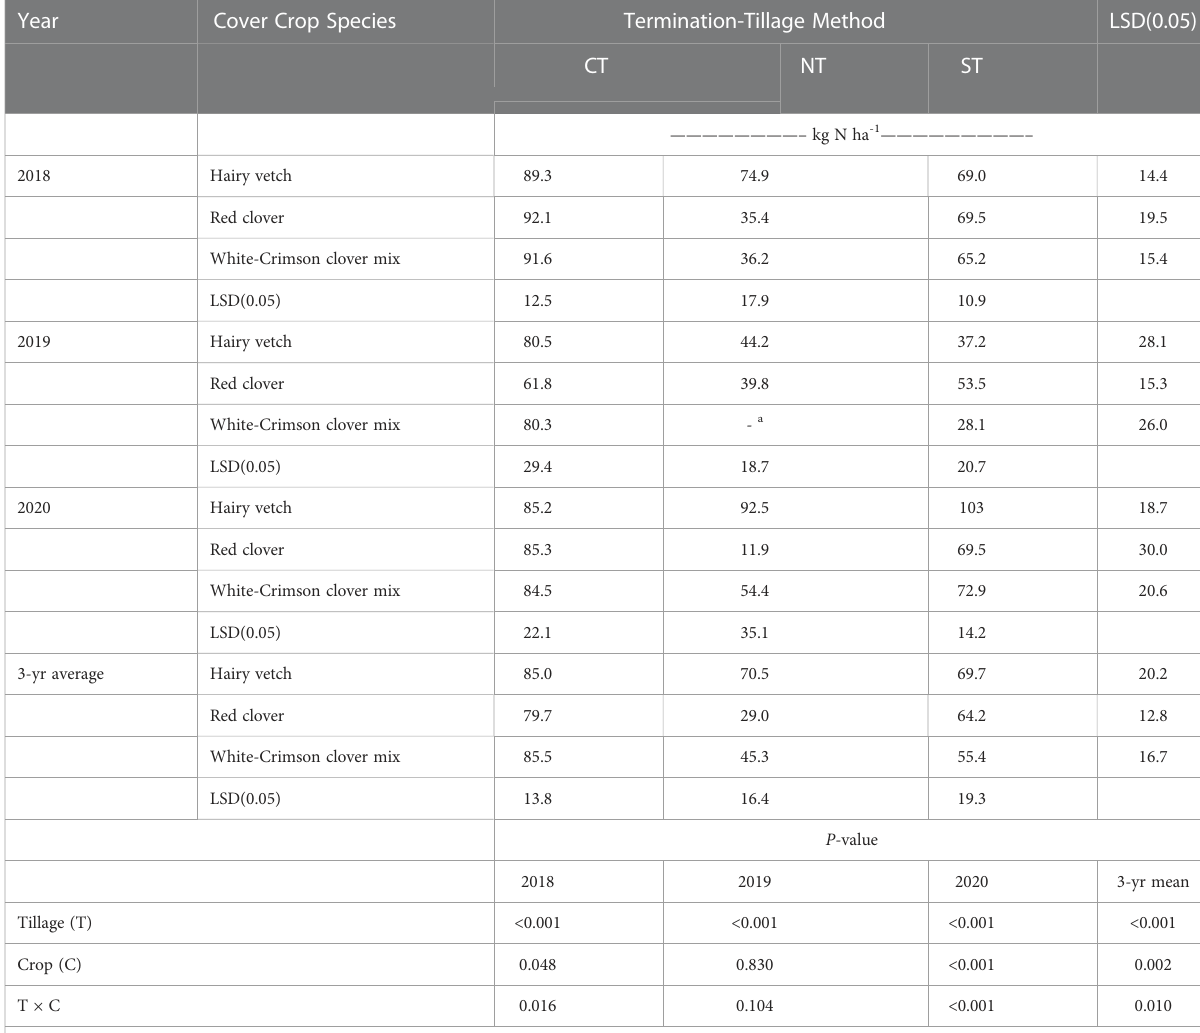
TABLE 6 Apparent fertilizer nitrogen replacement value, FNRV A (Eq. 1), to corn for different cover crop species and termination-tillage